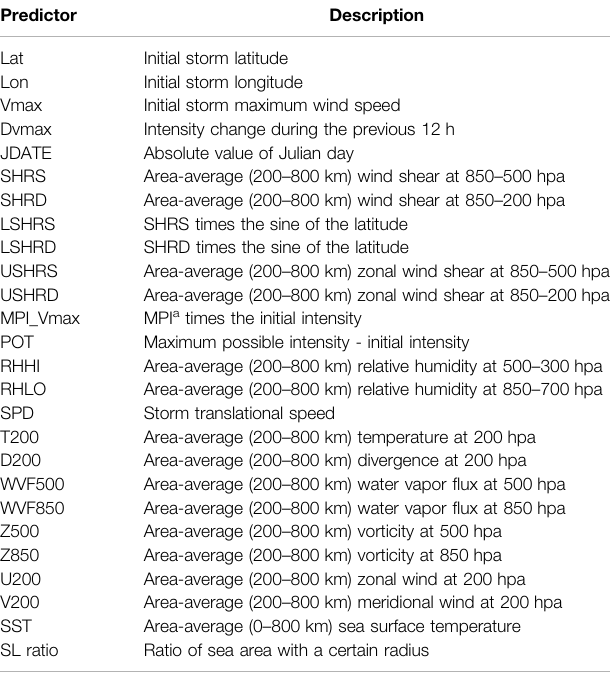
TABLE 1 | The 26 potential predictors available for the GBRT model. TABLE 2 | Sample numbers for different TCs ’ lead time prediction